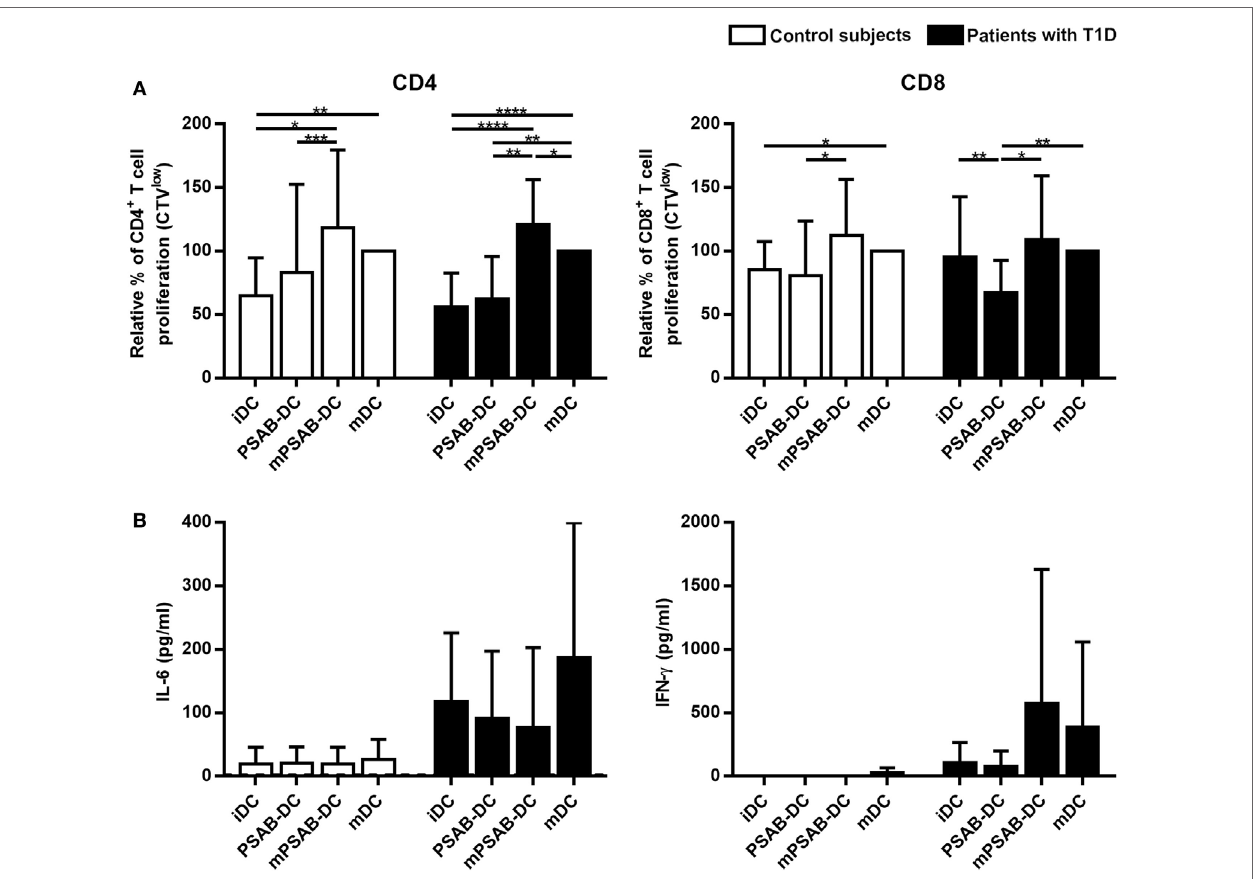
FigUre 5 | Capture of PSA-liposomes and PSB-liposomes affects dendritic cells (DCs) functionality. (a) Relative autologous proliferation of CD3 + CD4 + and CD3 + CD8 + subsets induced by DCs obtained from control subjects (white bars, n = 12) and patients with type 1 diabetes (T1D) (black bars, n ≥ 12). Autologous peripheral blood mononuclear cells were stained with CellTrace Violet (CTV) and co-cultured at 1:10 ratio for 6 days with each condition of DCs, and proliferation was measured as the percentage of CTV low cells. Bars represent immature DCs (iDCs), iDCs after the capture of PSA-liposomes and PSB-liposomes (PSAB-DCs), mature PSAB-DCs (mPSAB-DC), or mature DCs (mDCs). MDCs were induced by culture with cytokine cocktail. Data presented as mean ± SD of relative proliferation induction, this being the percentage of CTV low cells in each co-culture condition referred to that of their respective mDCs control. Significant differences were found when comparing culture conditions in the same group of subjects (* p ≤ 0.05, ** p < 0.01, *** p < 0.001, **** p < 0.0001, Wilcoxon test), and differences were not found when comparing the same culture conditions between patients with T1D and control subjects (Mann-Whitney test). (b) IL-6 and IFN- γ secretion (pg/ ml) assessed in supernatants of autologous proliferation co-culture with cells from control subjects (white bars, n ≥ 3) and patients with T1D (black bars, n ≥ 3). Bars represent immature DCs (iDCs), iDCs after the capture of PSA-liposomes and PSB-liposomes (PSAB-DCs), mature PSAB-DCs (mPSAB-DC), or mature DCs (mDCs). MDCs were induced by culture with cytokine cocktail. Data presented as mean ± SD. No differences were found when comparing the different conditions in the same group of subjects (Wilcoxon test), or when comparing the same culture conditions between patients with T1D and control subjects (Mann–Whitney